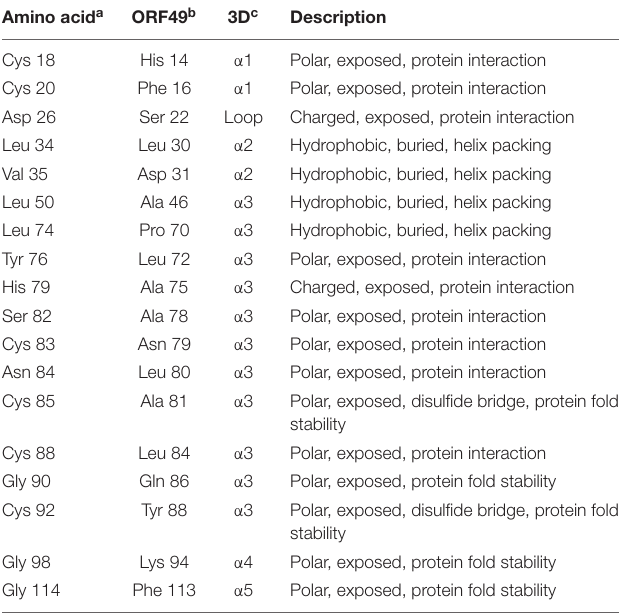
TABLE 1 | Summary of the predicted functional residues for the P15 family of